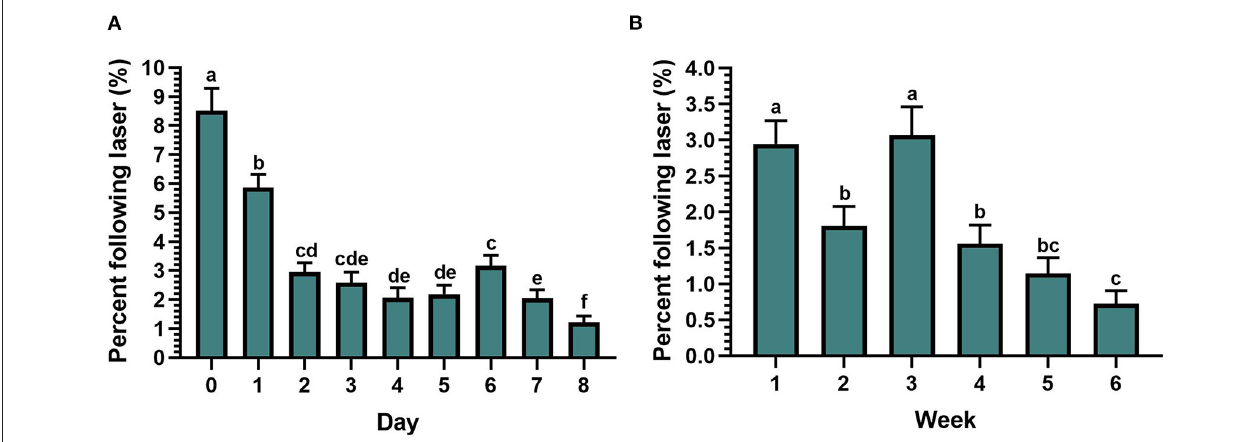
FIGURE 4 | Laser-following behavior over (A) d0–8 (day LSMeans ± SEM) and (B) wk 1–6 (week LSMeans ± SEM) in LASER-enriched pens only a . Following the first d0–8, Thursdays of each week were selected for behavior video recording. a Bars lacking common letters indicate means that are significantly different ( P ≤ 0.05).